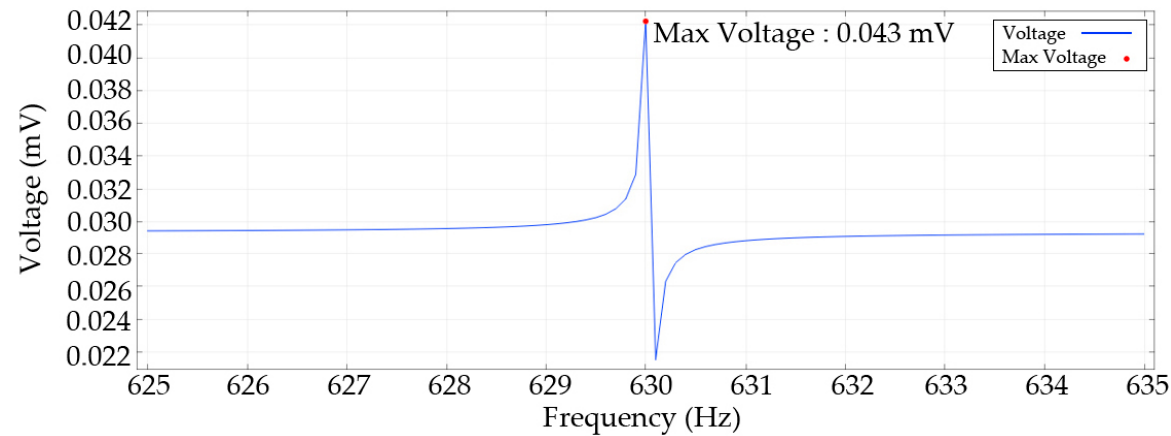
Figure 17. Output voltage from piezoelectric beam III at third mode shape.